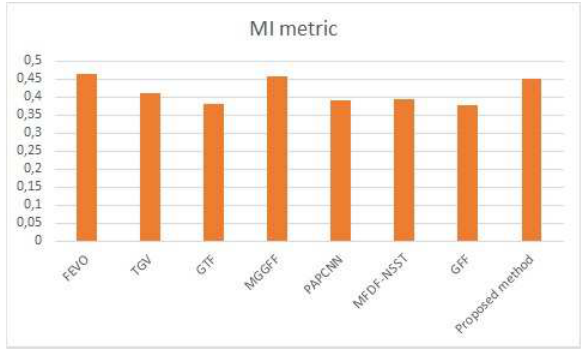
Figure 9. Diagram of the quality assessment by MI metric